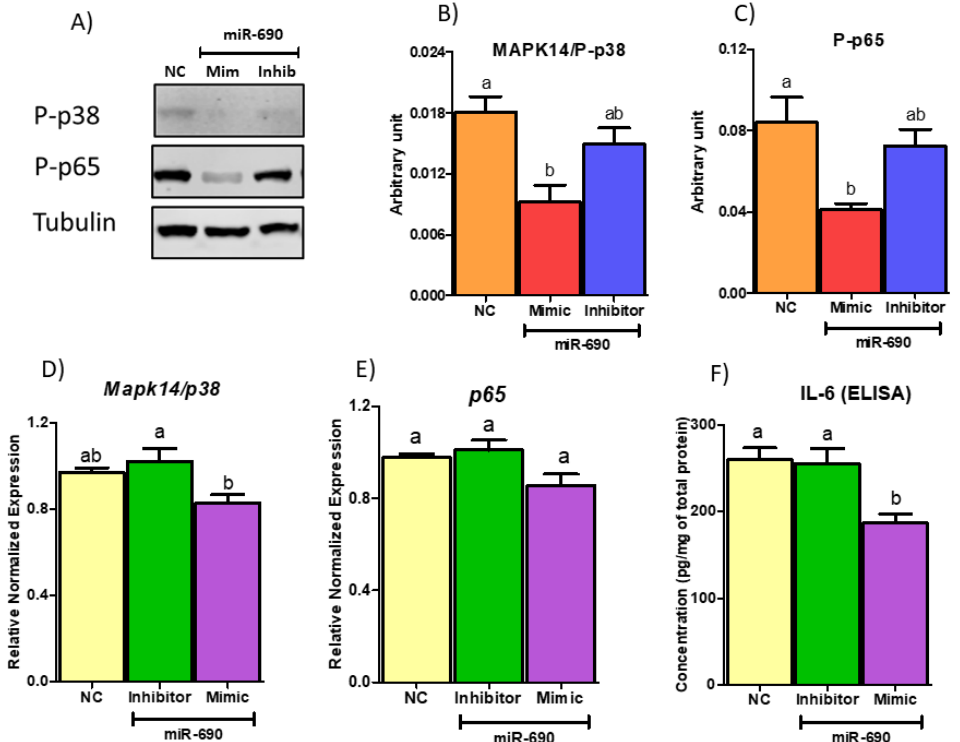
Figure 8. Targeting mitogen activated protein kinase kinase 3 ( Map2k3 ) by miR ‐ 690 reduces downstream inflammation and cell stress. ( A ) Western blot image of protein analysis. miR ‐ 690 mimic significantly reduced the amount of phospho ‐ p38 (P ‐ p38) and phospho ‐ p65 (P ‐ p65) at protein level compared to negative control (NC), whereas inhibitor ‐ treated groups had no differences in the protein amount compared to NC. (B) Quantification of P ‐ p38 protein normalized to Tubulin. (C) Graphical interpretation of P ‐ p65 protein level normalized to Tubulin level. ( D ) Mapk14/p38 did not show any significant reduction in messenger RNA (mRNA) level with miR ‐ 690 mimic or inhibitor treatments compared to NC. (E) Similar to p38, p65 showed no changes at mRNA levels among treatment groups. ( F ) Enzyme ‐ linked immunosorbent assay (ELISA) results. miR ‐ 690 mimic significantly reduced interleukin 6 (IL ‐ 6) level in media treated with miR ‐ 690 mimic compared to NC. Common letters on the error bars indicate no significance (e.g., “a” is significantly different from “b” and “ab” indicates no significance compared to “a” and “b”). Data are presented as mean ± SEM ( p < 0.05) ( n = 4).